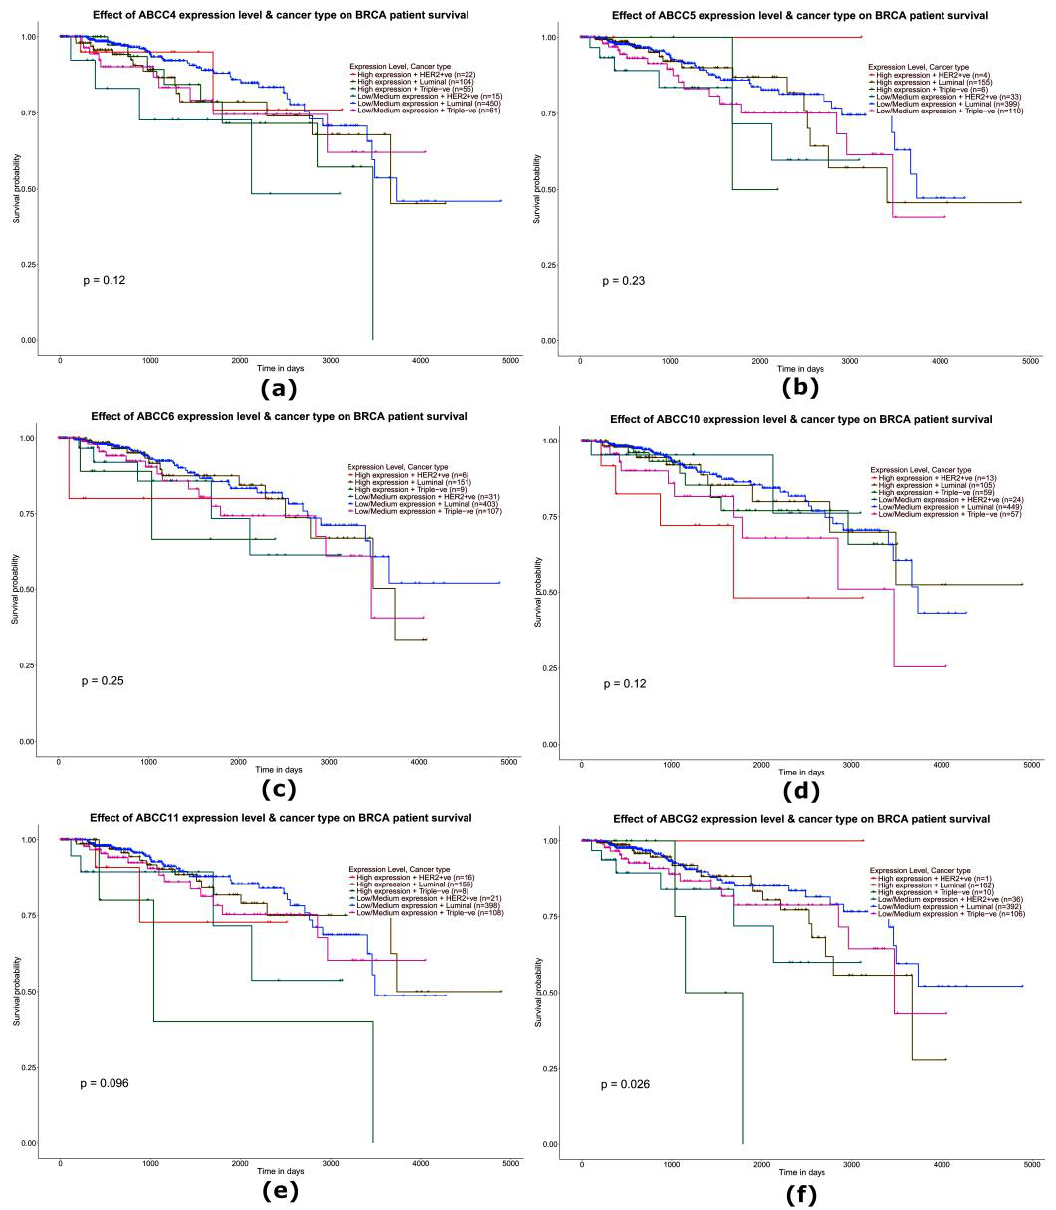
Figure 11. Survival curves (Kaplan–Meier plotter) including an assessment of the prognostic signif- icance of the ABCC4 ( a ), ABCC5 ( b ), ABCC6 ( c ), ABCC10 ( d ), ABCC11 ( e ), and ABCG2 ( f ) genes in patients with breast cancer (different molecular subtypes). The data were generated using the online tool Ualcan.